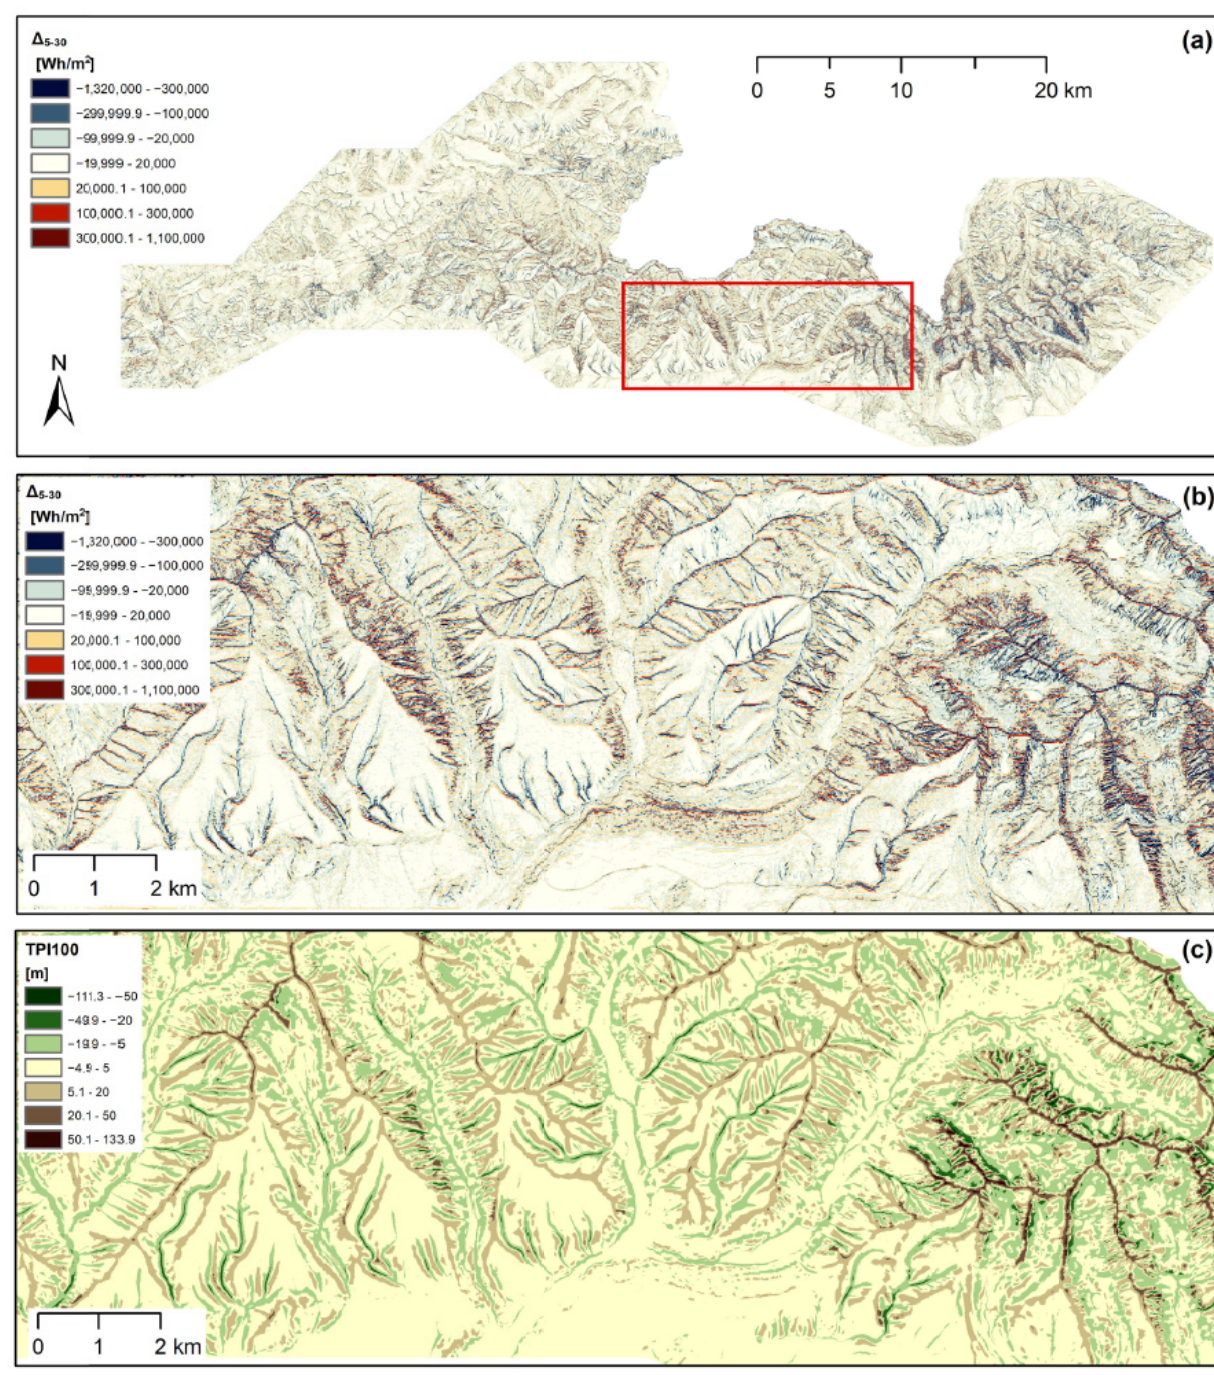
Figure 4. Differences between the potential solar radiation calculated at a resolution of 5 m and 30 m ( a , b ); TPI calculated with an input circular neighbourhood of 100 m ( c ). Data source: Ú GKK SR [45]. 3.2. Correlations between Absolute Values of Potential Solar Radiation Differences and the Terrain